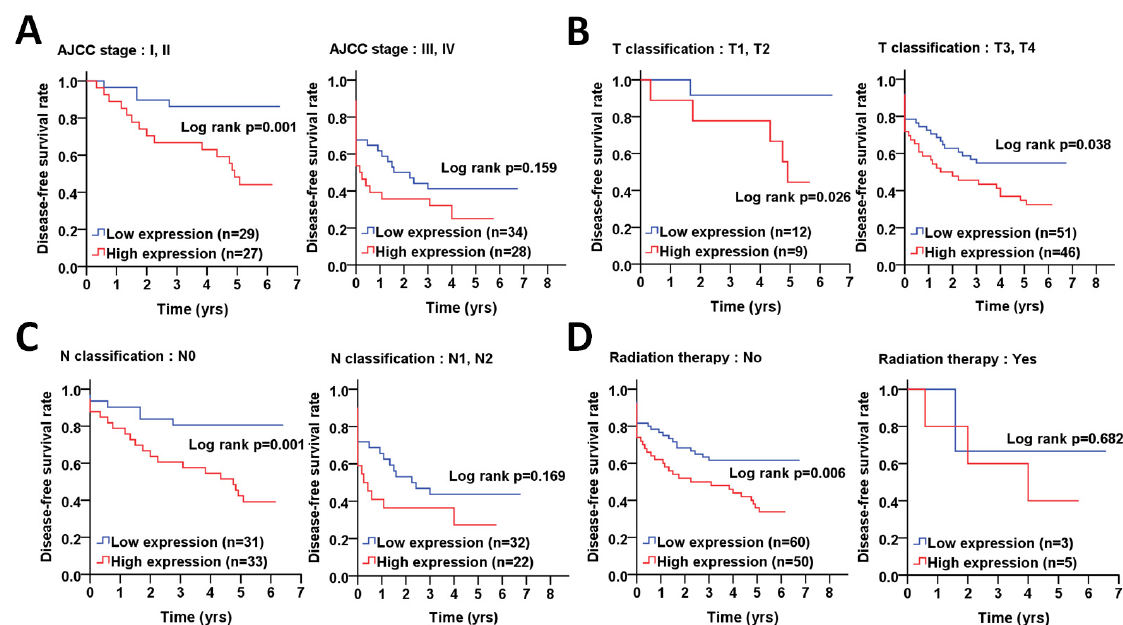
Figure 5. The correlation of ATG5 protein levels with DFS in CRC patients with certain pathological stages and radiation therapy. ( A ) The CRC patients were stratified into early and advanced pathological stages, including AJCC, ( B ) tumor size (T stages), ( C ) lymph nodes invasion (N stages), and ( D ) radiation therapy. The association of ATG5 protein level in tumor tissues with DFS was analyzed by Kaplan–Meier plots. The ROC curve was used to determine the cutoff values to differentiate the high (red) or low (low) ATG5 protein levels in tumor tissues. The log rank was used to determine the significance of ATG5 protein levels on DFS of CRC patients.